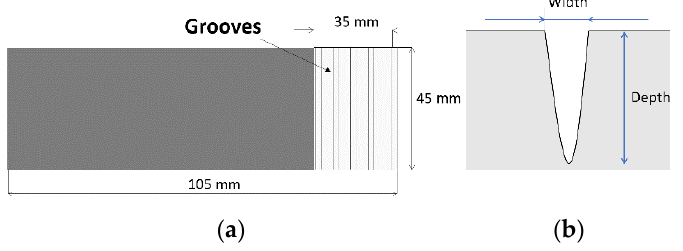
Figure 1. ( a ) Textured specimen dimensions and ( b ) textured groove.